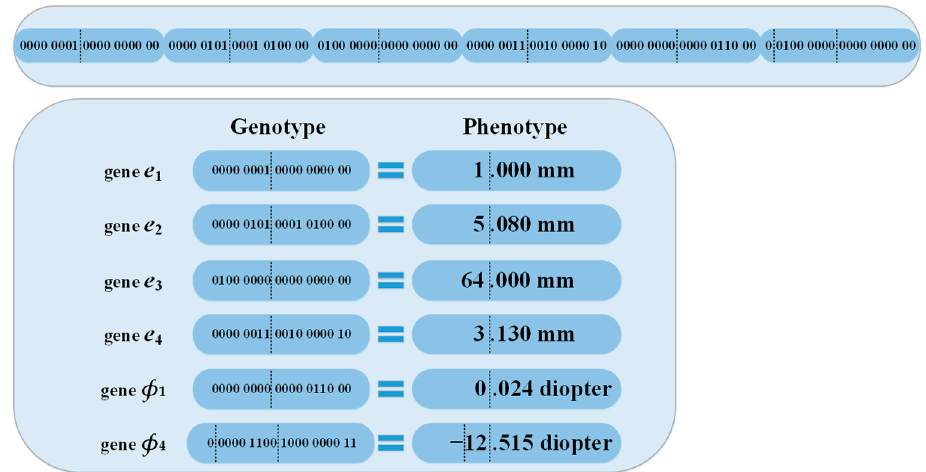
Figure 6. Translation rule.